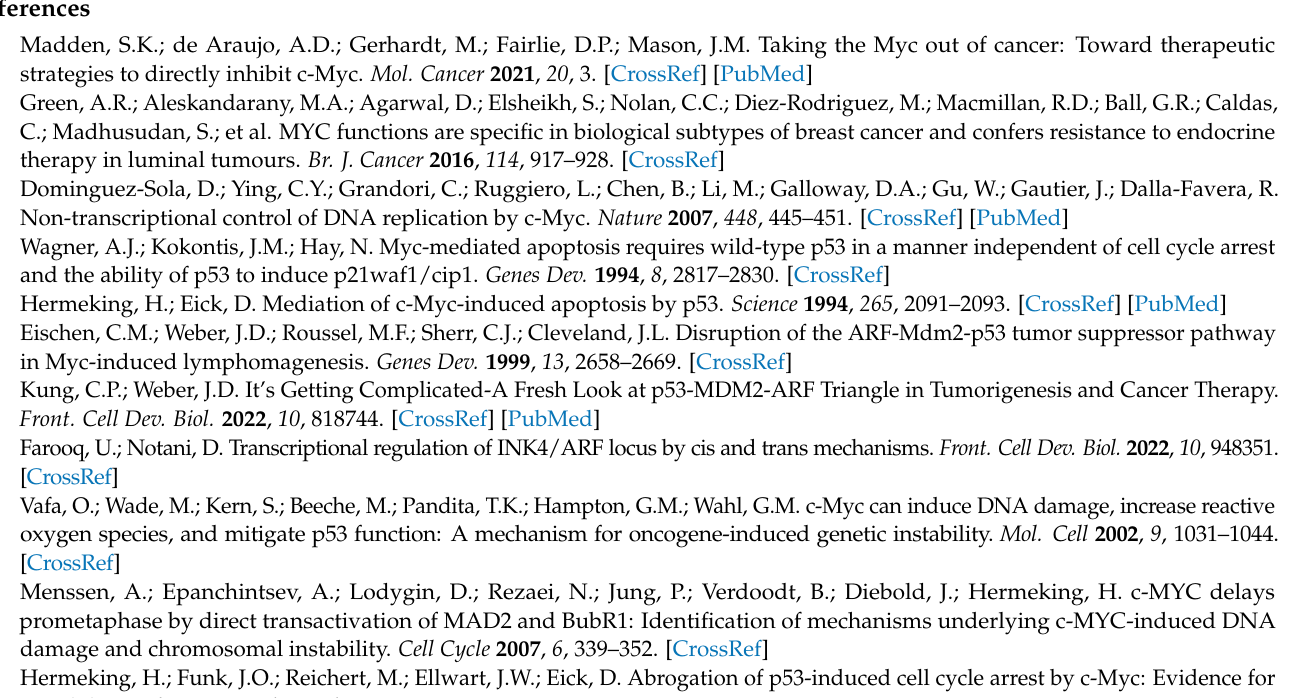
for AP4 deletion. Table S2: Sequence information for guide p53 used for p53 deletion. Table S3: List of Antibodies used. Table S4: Oligonucleotides used for qPCR. Table S5: mRNAs significantly up- or downregulated ( ≥ 1.5 × fold change) in MCF-7/pRTR-c-MYC cells ( AP4 wild-type/ p53 wild-type). Table S6: mRNAs significantly up- or downregulated ( ≥ 1.5 × fold change) in MCF-7/pRTR-c-MYC cells ( AP4 KO/ p53 wild-type). Table S7: mRNAs significantly up- or downregulated ( ≥ 1.5 × fold change) in MCF-7/pRTR-c-MYC cells ( AP4 wild-type/ p53 − / − ). Table S8: mRNAs significantly up- or downregulated ( ≥ 1.5 × fold change) in MCF-7/pRTR-c-MYC cells ( AP4 KO/ p53 − / − ). Table S9: 2309 mRNAs with genotype-dependent differences in c-MYC-induced regulation. Table S10: E2F/DREAM targets associated with transcriptional clusters 1, 2 and